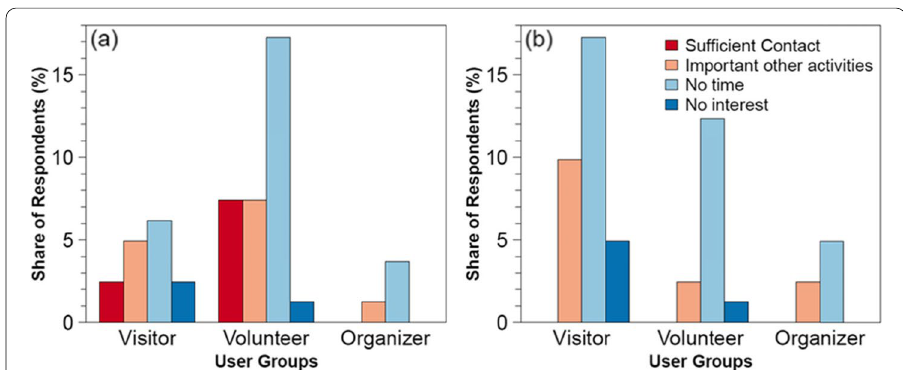
Fig. 4 Barriers for increasing participation in the Repair Cafe by share of respondents and user group. Chart ( a ) is male respondents. Chart ( b ) is female